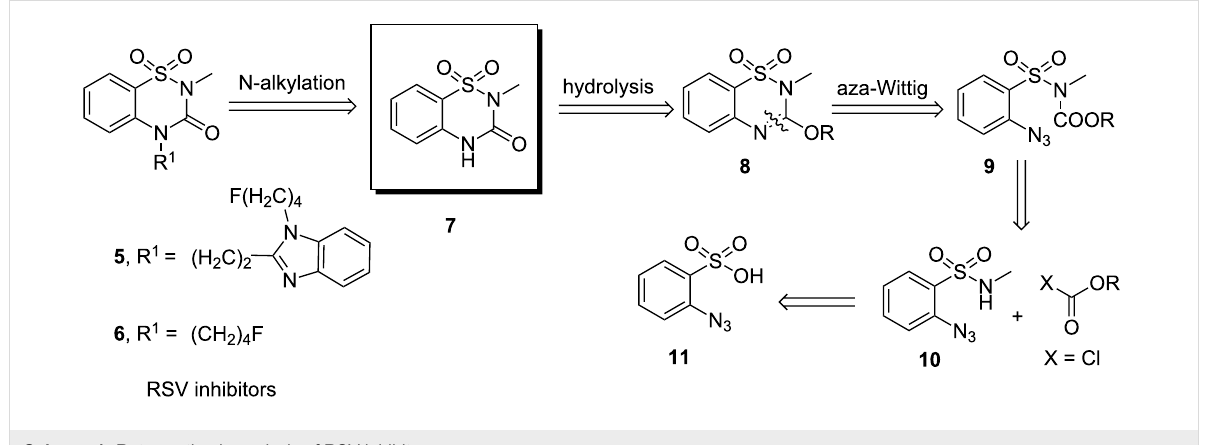
Scheme 1: Retrosynthesis analysis of RSV